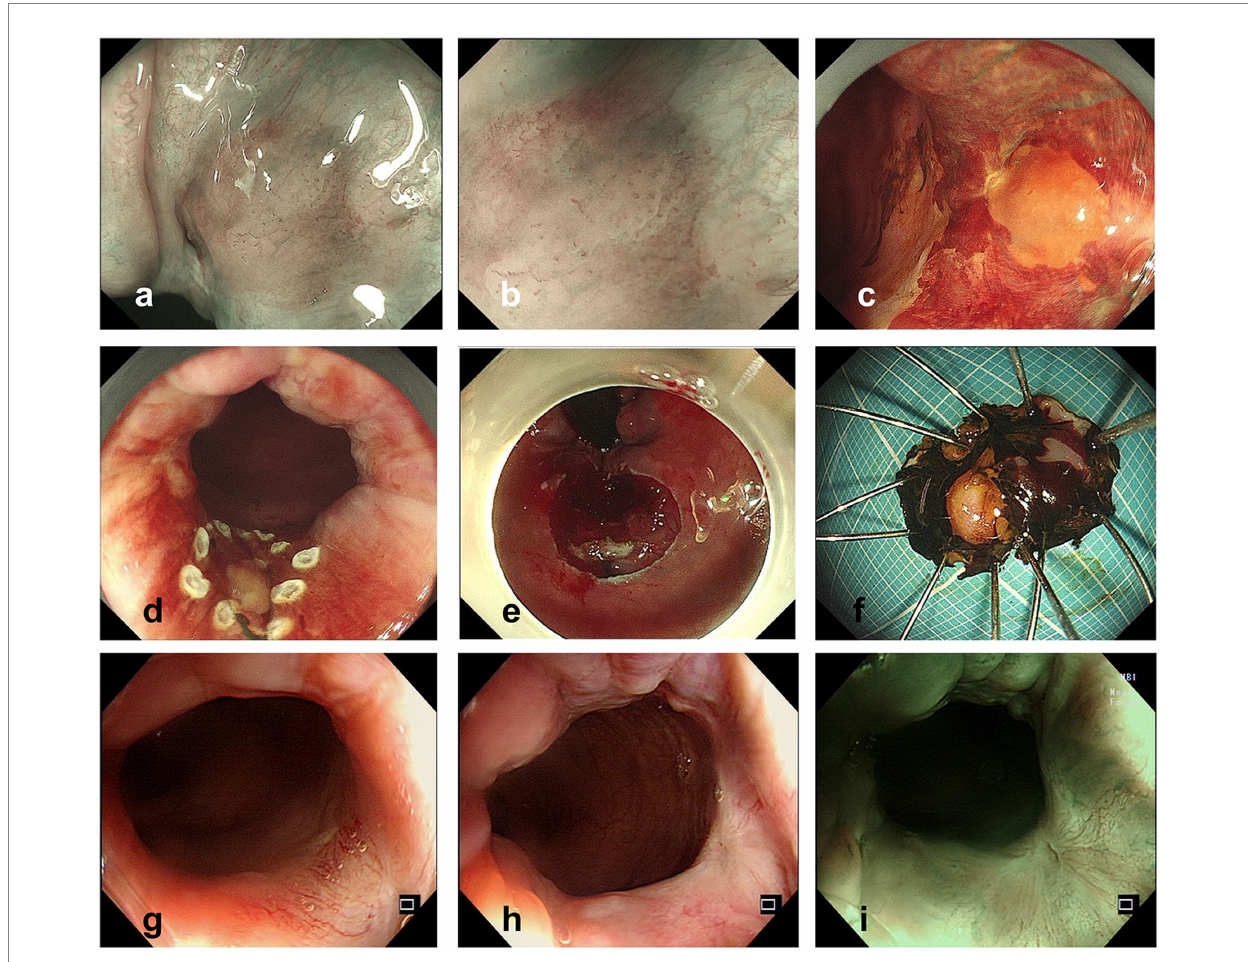
FIGURE 2 (A,B) Lesion observed with NBI (A) and ME-NBI (B) before ESD. (C) Lesion observed after iodine spraying. (D,E) Operation procedure of ESD. (F) Specimen resected by ESD (after iodine spraying). (G–I) Colonoscopy follow-up pictures 1 year after